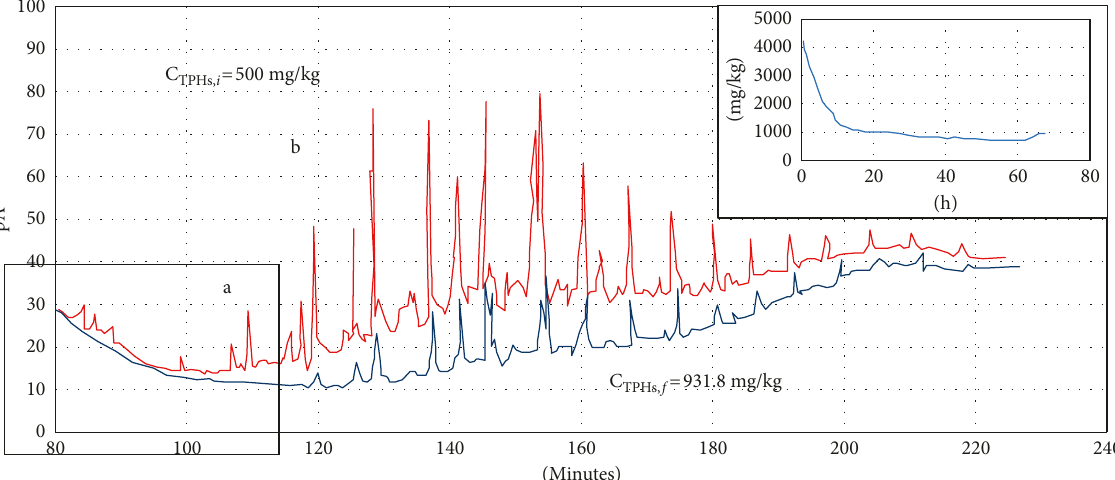
Figure 6: Chromatogram of TPHs derivatives: before and after treatment with